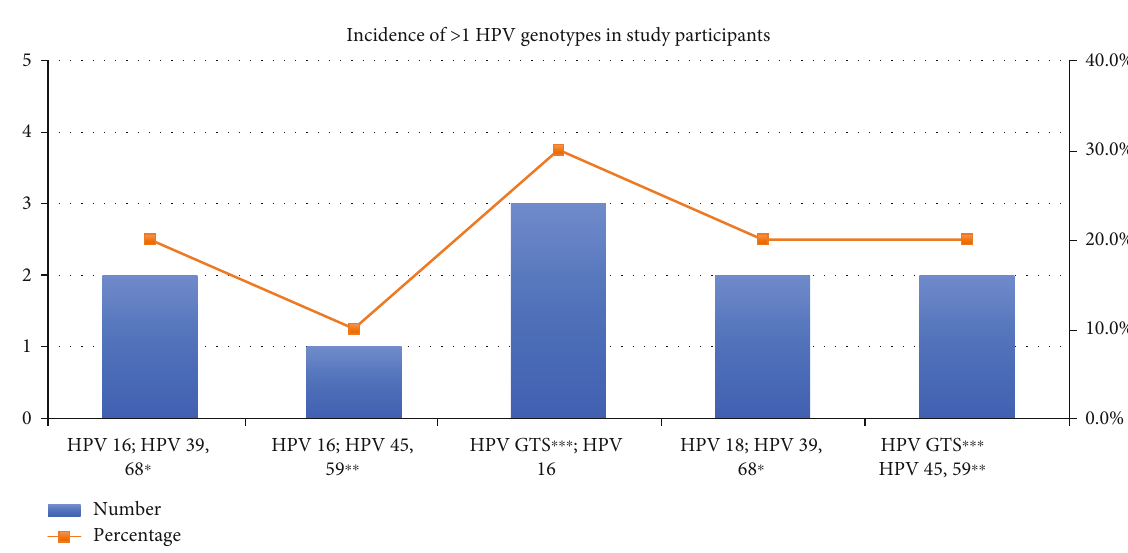
Figure 4: Distribution of mixed HPV genotypes in study participants. Table 3: HPV genotype distribution in cancerous and precancerous patients with HPV detected ( n = 48